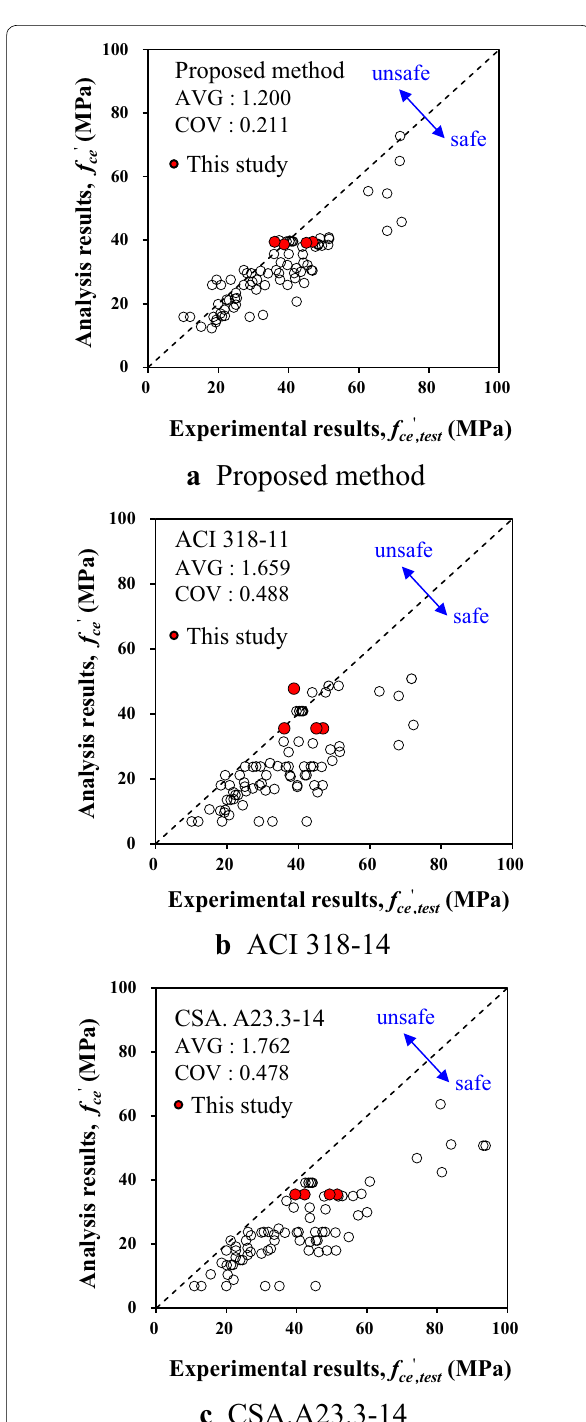
Fig. 8 Comparisons of test and analysis